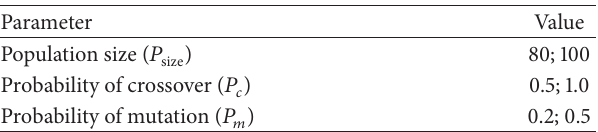
Table 6: Parameter values used to assess the proposed genetic algorithm.